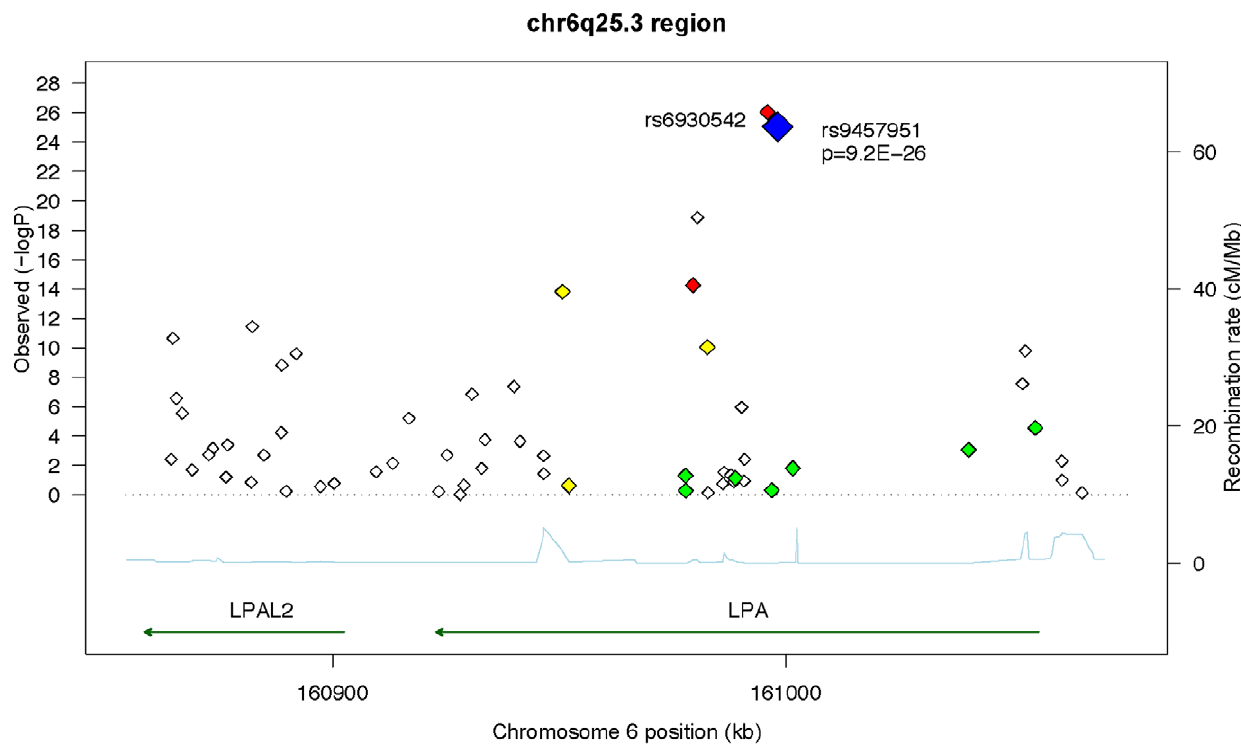
Figure 2. Graphical Depiction of SNP-Lp(a) Associations in the 6q25.3 region. For each SNP, -log(p-values) given in Table S1 are shown against chromosomal position (kb). rs9457951 is highlighted in blue, and SNPs in strong (r 2 $ 0.8), moderate (0.8 . r 2 $ 0.25) and weak(0.25 . r 2 $ 0.10) and very weak (0.1 . r 2 ) linkage disequilibrium with rs9457951 in the Yoruba HapMap population are depicted by red, yellow, green, and white diamonds, respectively. The position of the LPA and LPAL2 genes are depicted by green arrows. The chromosomal recombination rate for the Yoruba population is depicted at the bottom of the plot, in light blue.